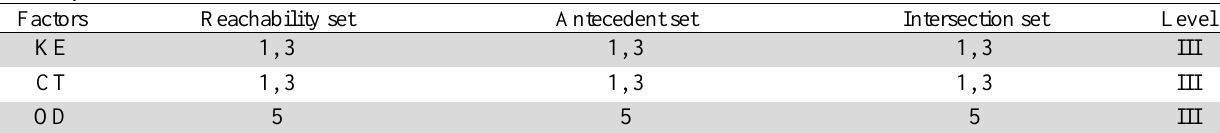
Level partition—iteration 3